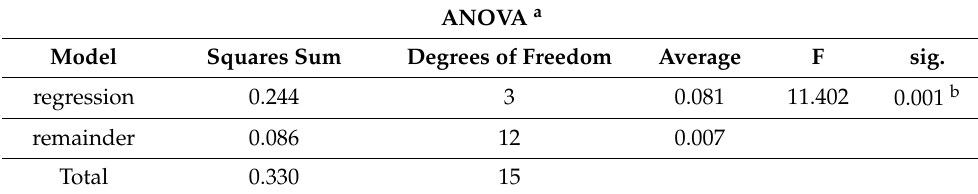
Table 14. Analysis of variance for strain model of CDWRCer. ANOVA a Model Squares Sum Degrees of Freedom Average F sig.